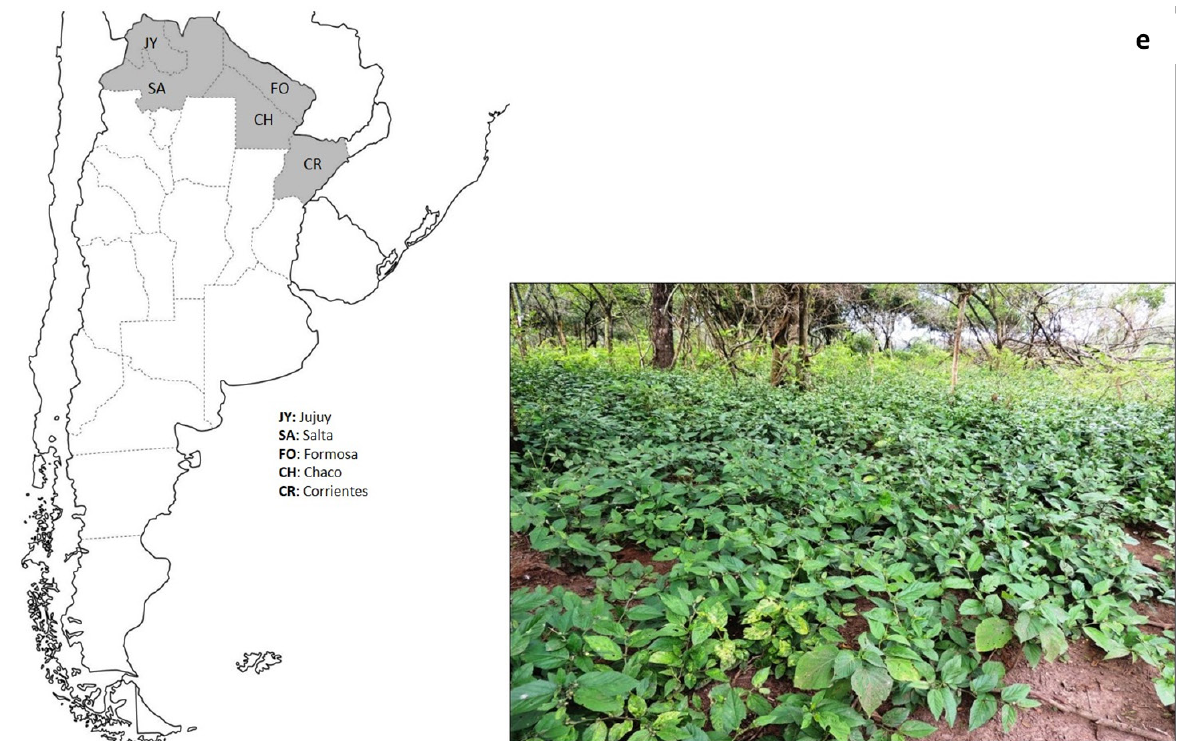
Figure 2e. Distribution of Sida rodrigoi in